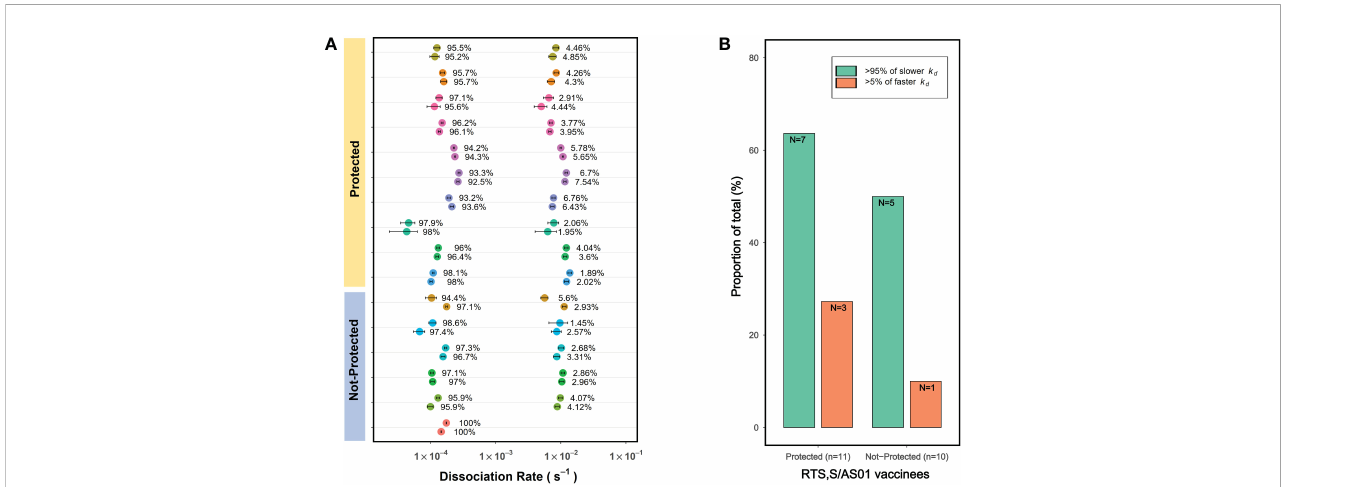
FIGURE 8 PAART analysis resolves differences in avidity heterogeneity between protected and infected malaria vaccinees in a phase 2 clinical trial. (A) The k d values derived from PAART analysis of dissociation time-courses of 1:50 diluted sera from visit 20 corresponding to post-immune 3 (Day of Challenge) time point are shown for standard dose regimen RTS,S/AS01 vaccinees. Two best replicates data from PAART analysis are shown. (B) The proportion of total vaccinees from the protected and not-protected groups with >95% of slower k d and >5% of faster k d are shown. Binding responses were below the dissociation rate quanti fi able limit for 1 and 4 vaccinees from the protected and not-protected groups respectively. In panel A, the error bars associated with symbols indicate the standard error in the estimate of k d